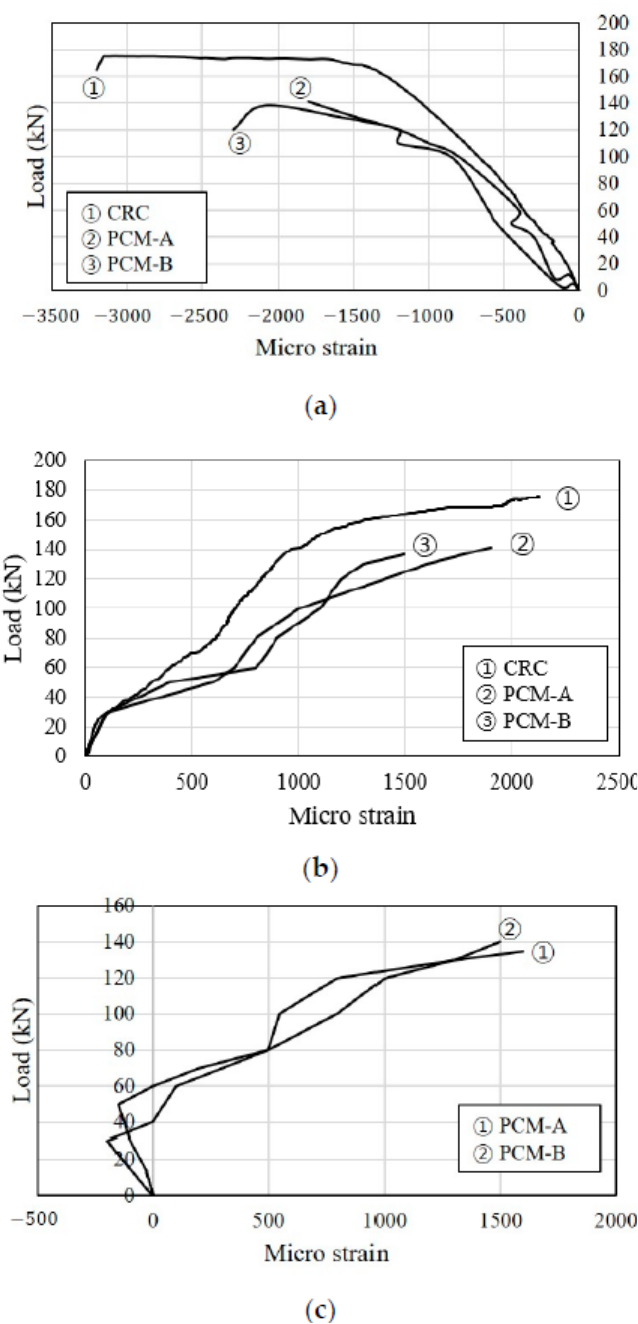
Figure 15. Comparison of strain gauges: ( a ) concrete strain gauge; ( b ) rebar strain gauge; ( c ) steel plate strain